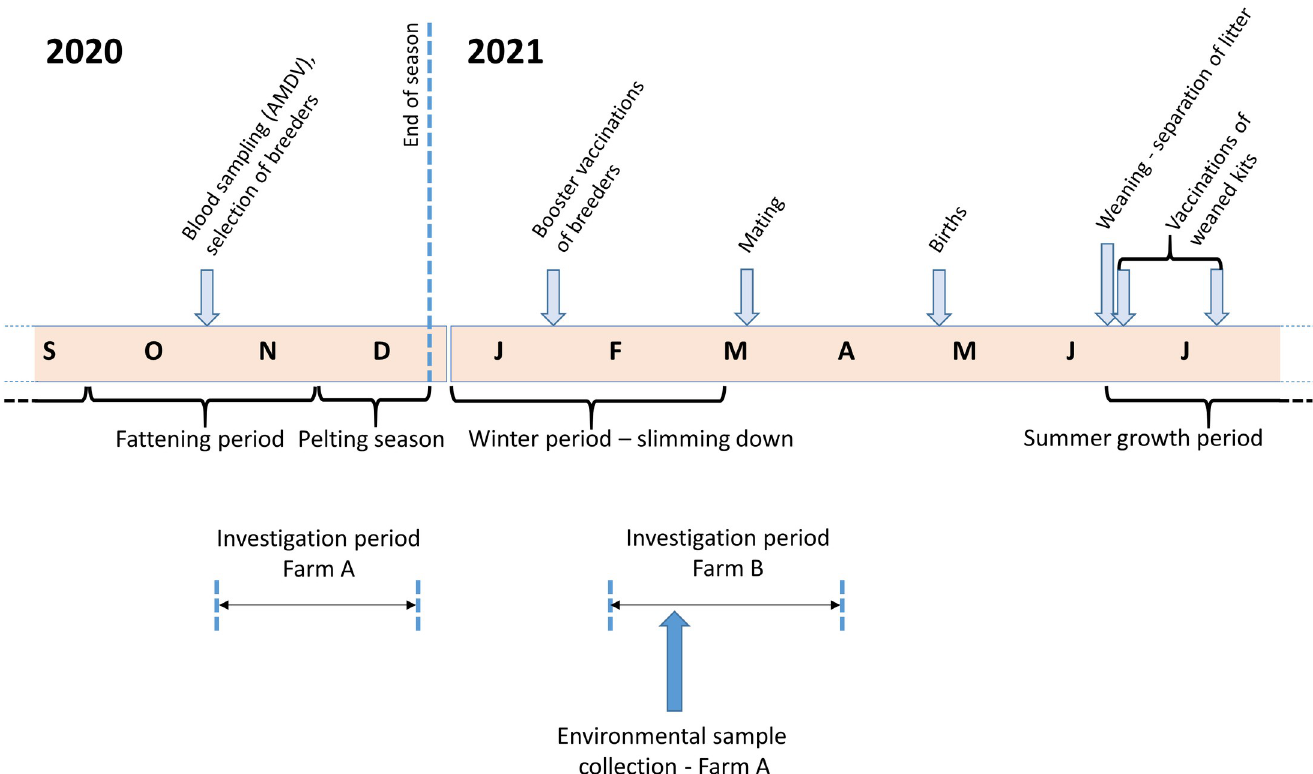
Fig 1. Annual cycle of mink farming and associated procedures of the breeding process. The periods wherein the farms of the present study were investigated are indicated.